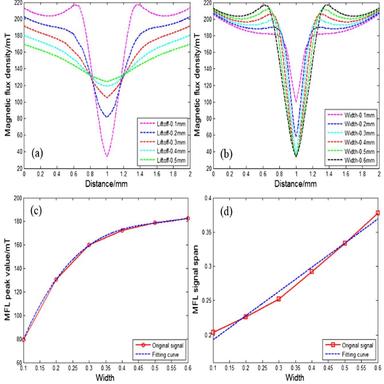
MFL signals and characterizations of triangular defect; (a) MFL signals of triangular defect in different liftoff values with the width of 0.6 mm; (b) MFL signals of triangular defects in different widths with the liftoff of 0.1 mm; (c) Relationships between MFL peak values in (b) and triangular defect widths; (d) Relationships between MFL signal spans in (b) and triangular defect widths.